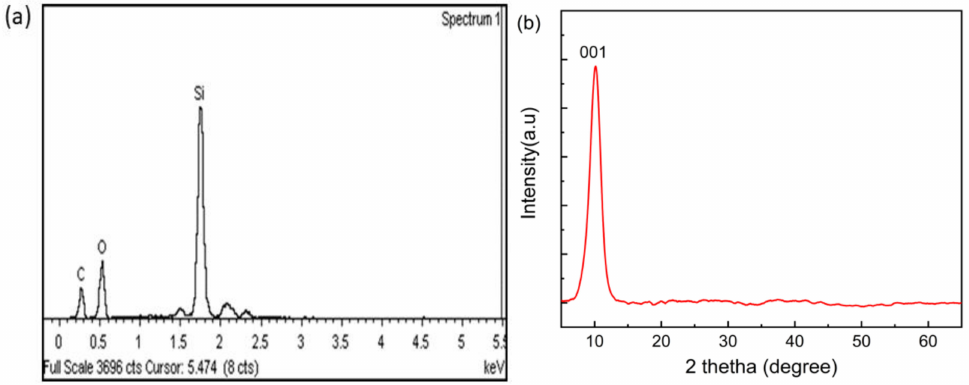
Figure 5. ( a ) Energy dispersion X-ray (EDX) spectrum of the GO-coated optical microfibers; ( b ) X-ray diffractometer (XRD) pattern of the prepared